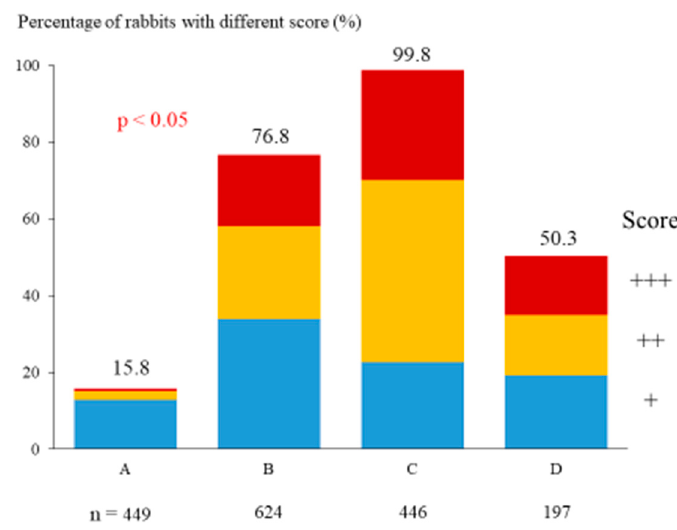
Figure 7. Influence of floor design on frequency of polluted rabbits at the end of the growing period.